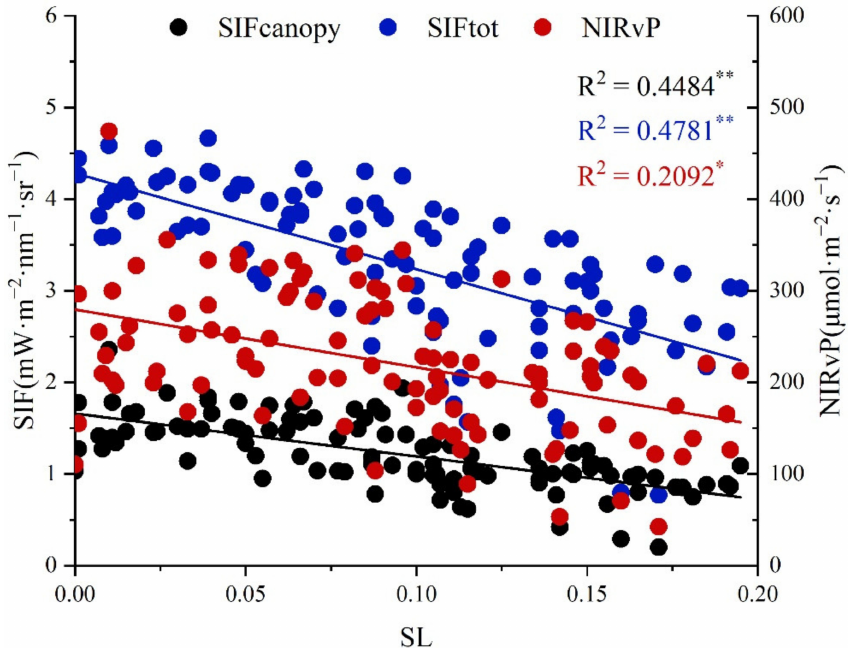
Figure 5. Overview of the relationships between the severity level (SL) of disease and SIF canopy - related variables at a mild stage of disease onset ( n = 104). Where ** indicates extremely significance at p < 0.001 level, * indicates extremely significance at p < 0.05